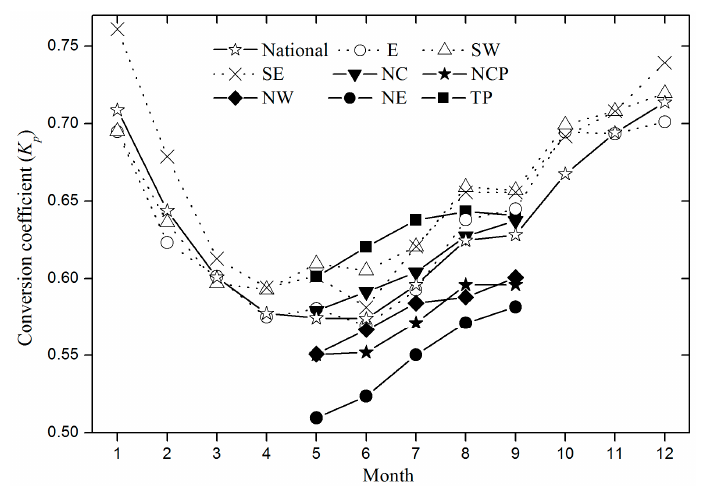
Figure 5. Monthly variation in the conversion coefficient (K p ) of E601B and φ 20 pan evaporation in the eight climate regions. The K p values in the three humid regions (E, SE, and SW) are illustrated by dotted lines, and the K p values in the four non ‐ humid regions and TP region are illustrated by solid lines during the warm season (May–September). The national K p is illustrated by the solid black line with open star symbols.